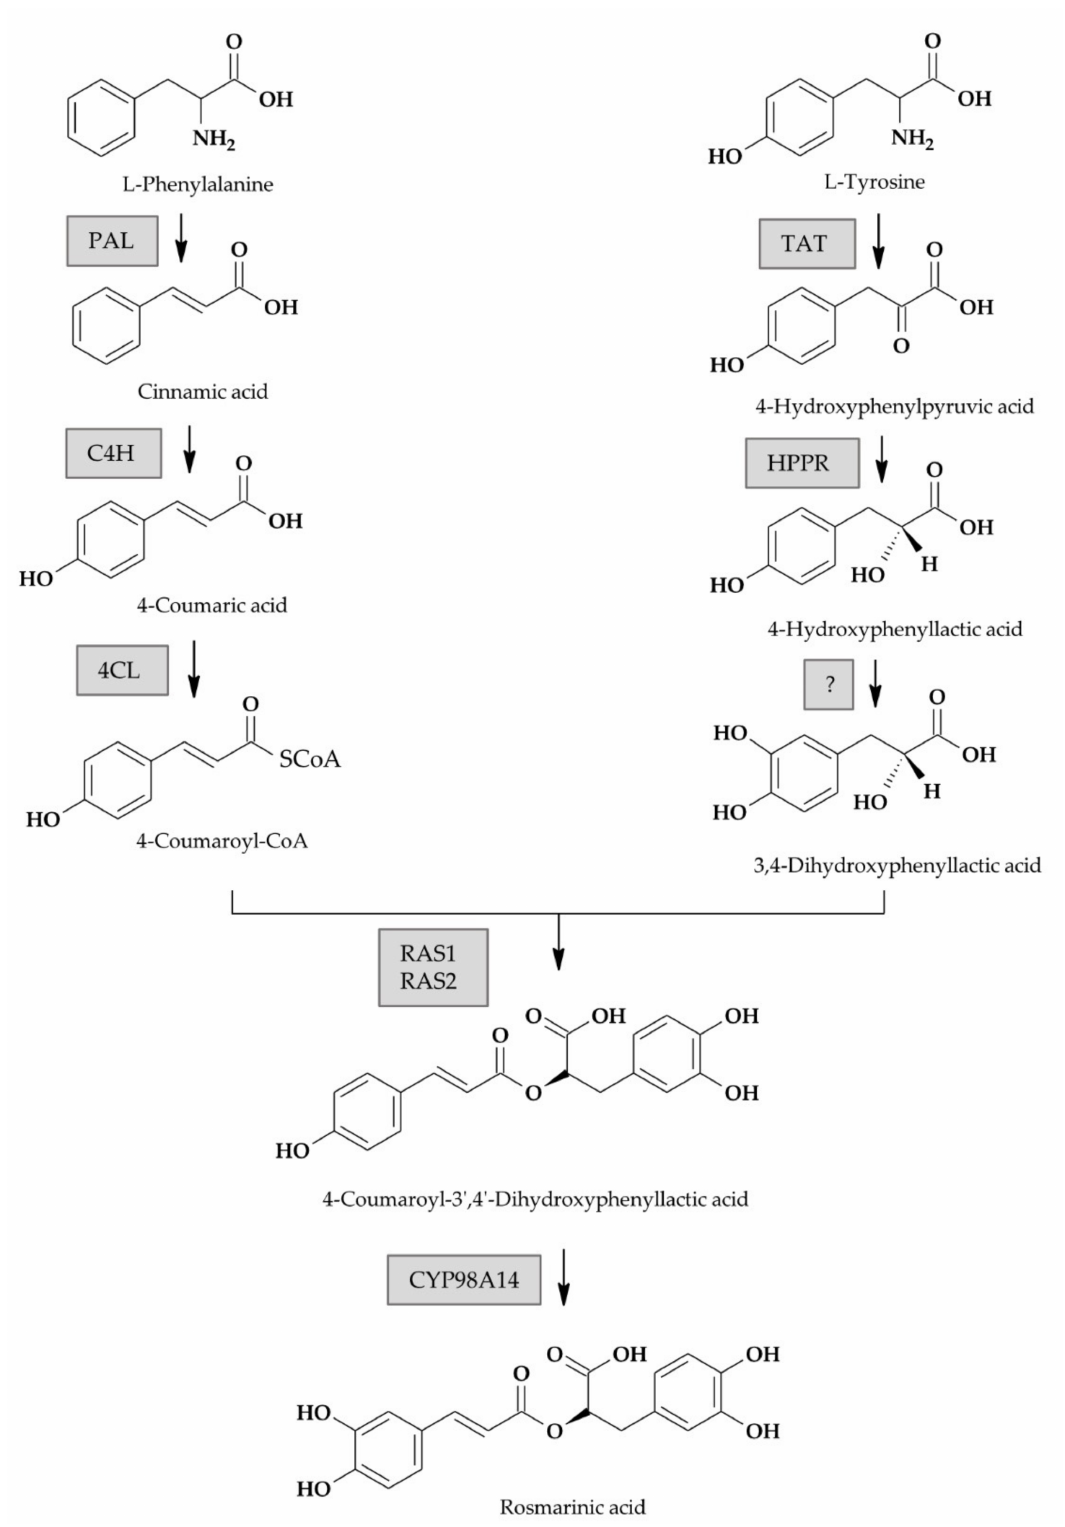
Figure 1. Putative biosynthetic pathway of rosmarinic acid according to previous studies on S. miltiorrhiza , a close relative of S. yangii and S. abrotanoides [7,26,27,29,30] Framed are genes investigated in this study. ( PAL , phenylalanine ammonia lyase; C4H , cinnamate 4-hydroxylase; 4CL , 4-coumaryl-CoA ligase; TAT , tyrosine aminotransferase; HPPR , hydroxyphenylpyruvate reductase; RAS1 and RAS2 , two isoforms of rosmarinic acid synthase; Cyp98A14, cytochrome P450-dependent